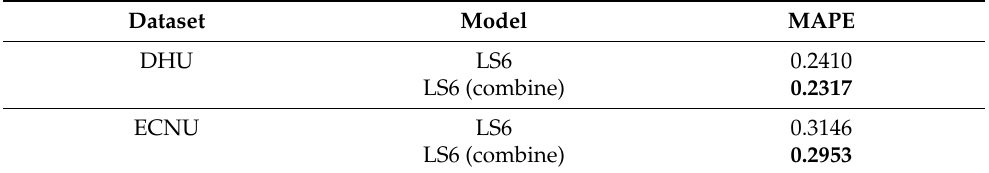
Table 5. Prediction performance of LS6 trained with a single training data and combined training